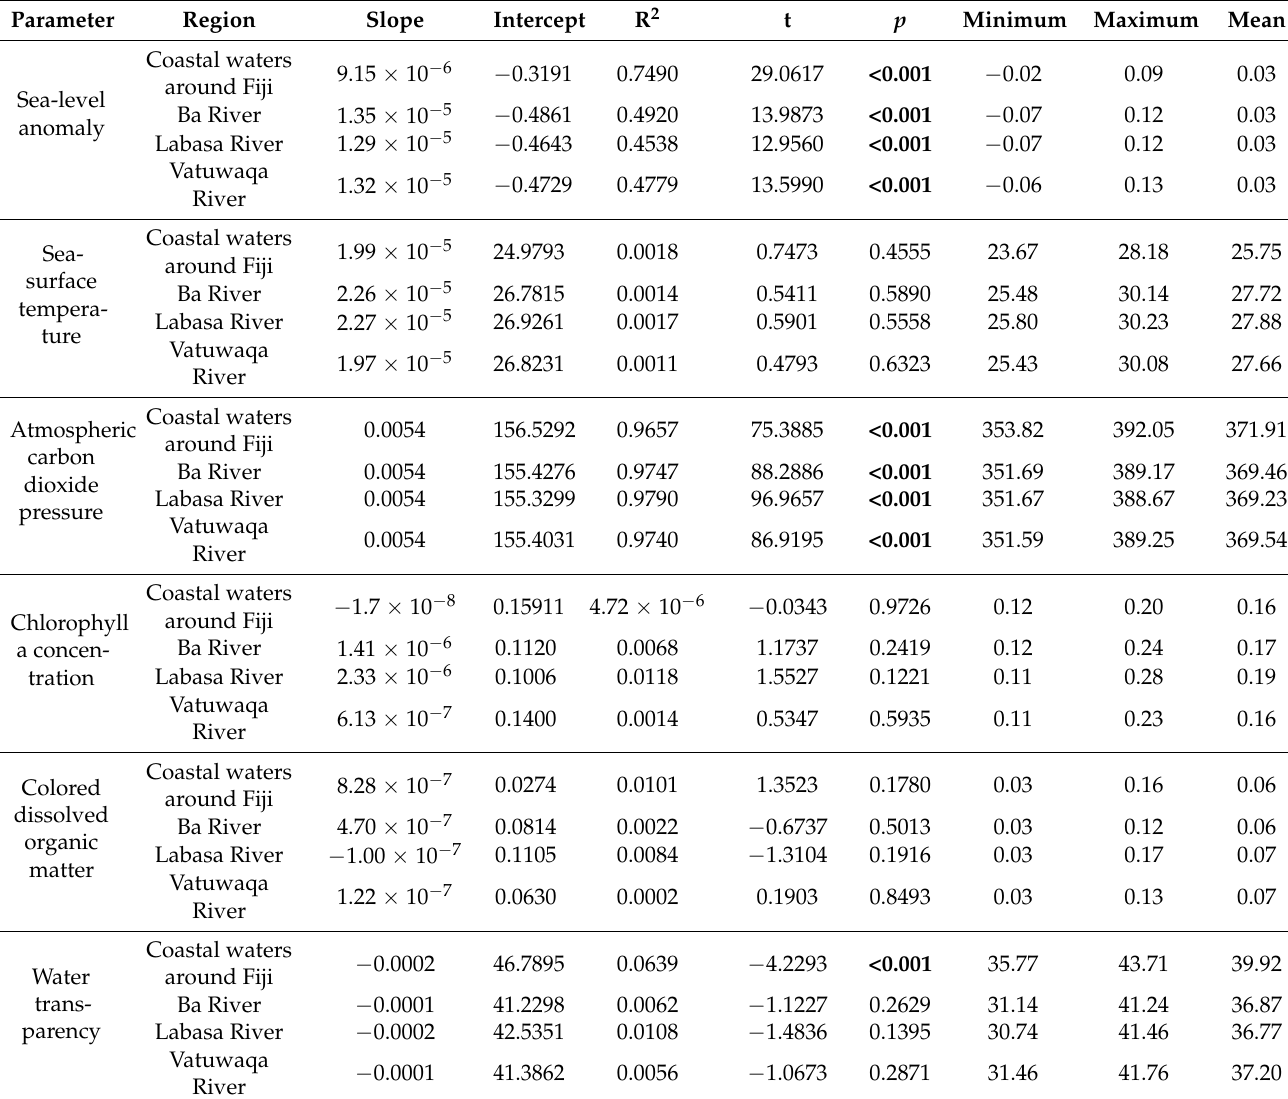
Table 5. Regression statistical analysis of water environment